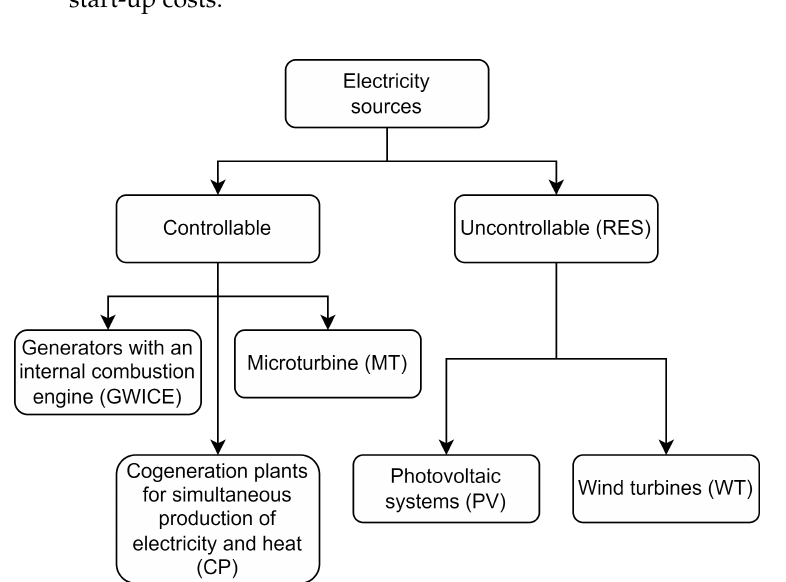
Figure 4. Overview and division of electricity